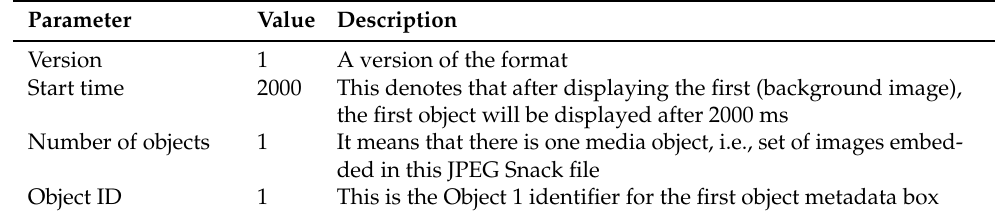
Table A5. Values of the JSDB parameters.